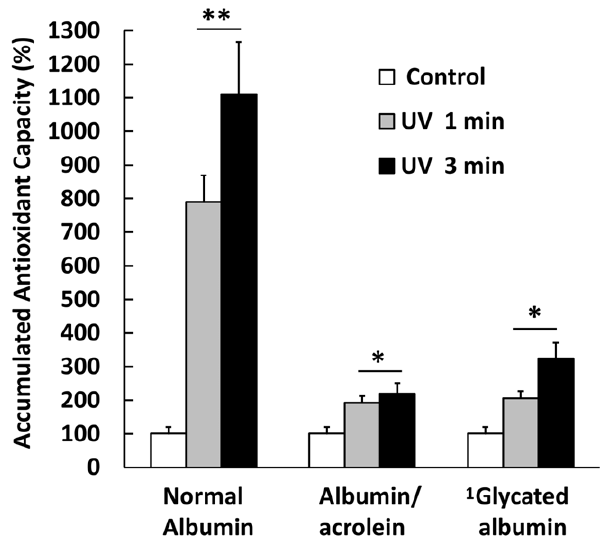
Figure 9. Response Surplus (RS) produced by albumin modified by acrolein and glucose. Structural modifications introduced by acrolein and glucose impaired the RS of the protein by a high magnitude. Normal albumin exposed to UV light responds to the stressor with an increase of 8 and up to 11 times the base value (100%) even before 1 and 3 minutes of exposure respectively (ACA%=800% and 1100%). In contrast, samples of albumin modified with acrolein and partially glycated respond with increases of 2.2 and 3.2 times the base value of 100%. Base value corresponds to the Antioxidant Capacity average before exposure to UV light, and appears as 100% in the graph. Results are expressed as mean 6 SD (n=5). *P , 0.005 vs. albumin control; **P , 0.001 vs. native albumin. 1 Partially glycated as described in the Material and Methods section.